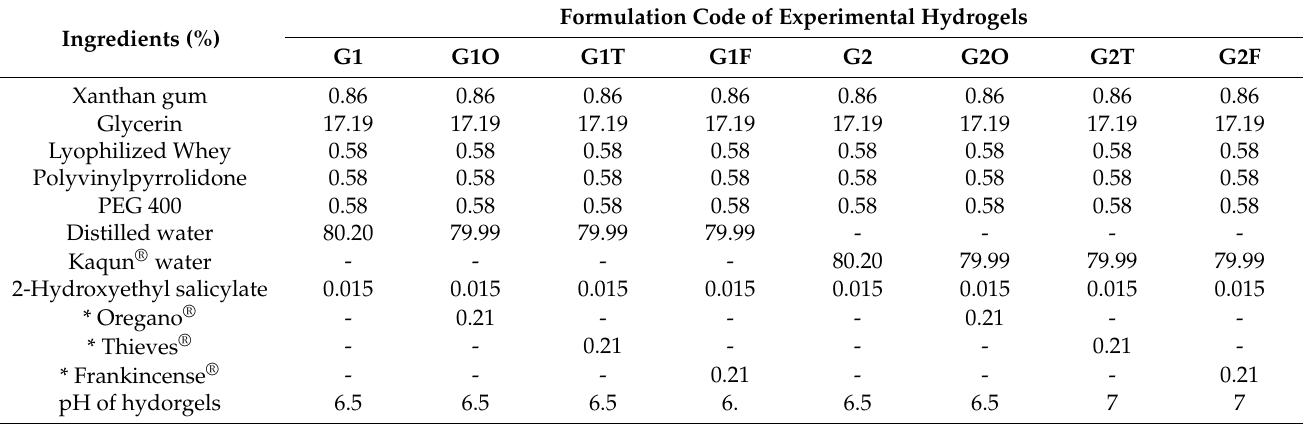
Table 4. The chemical composition and the pH of the experimental hydrogels based on essential